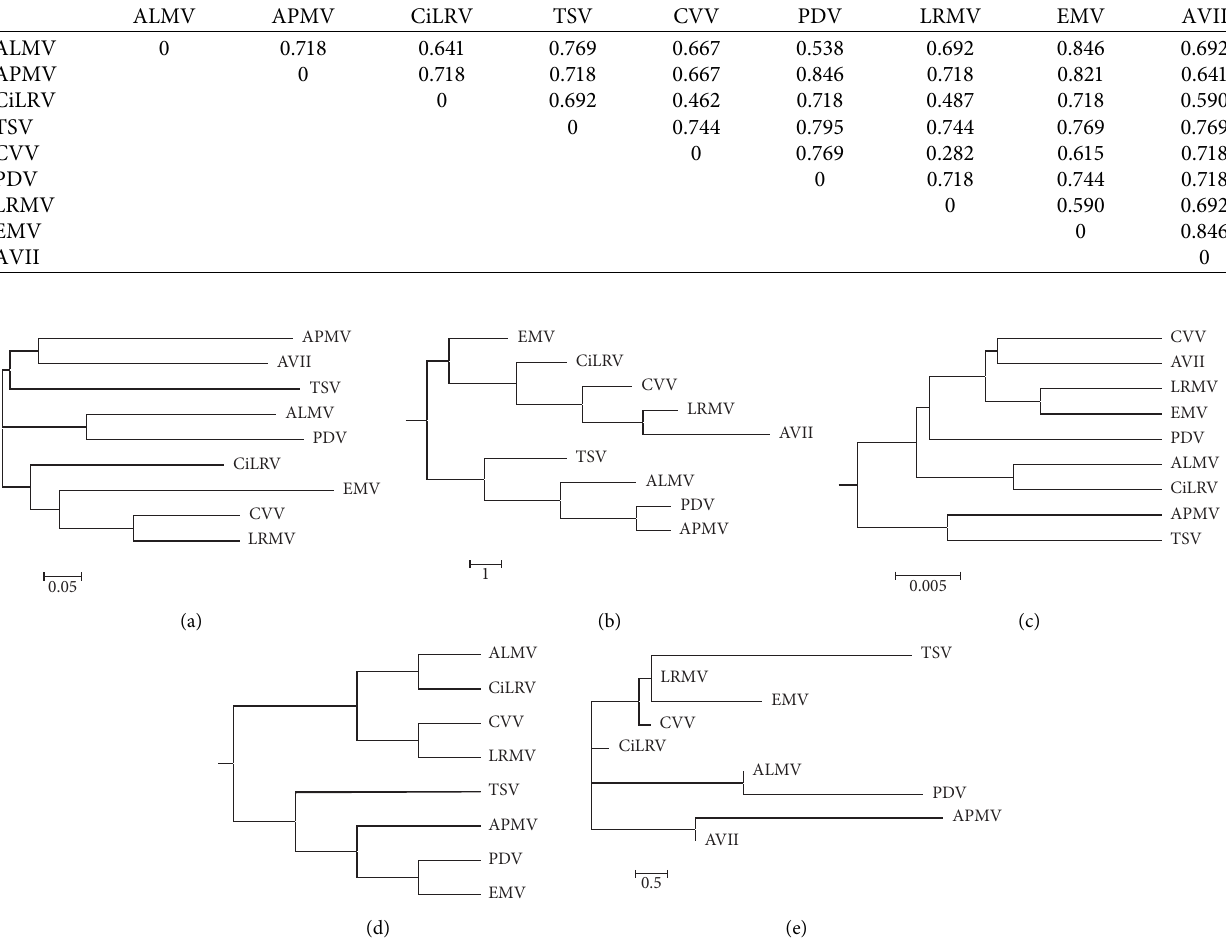
Table 1: The distance matrix of nine viruses generated by our method.